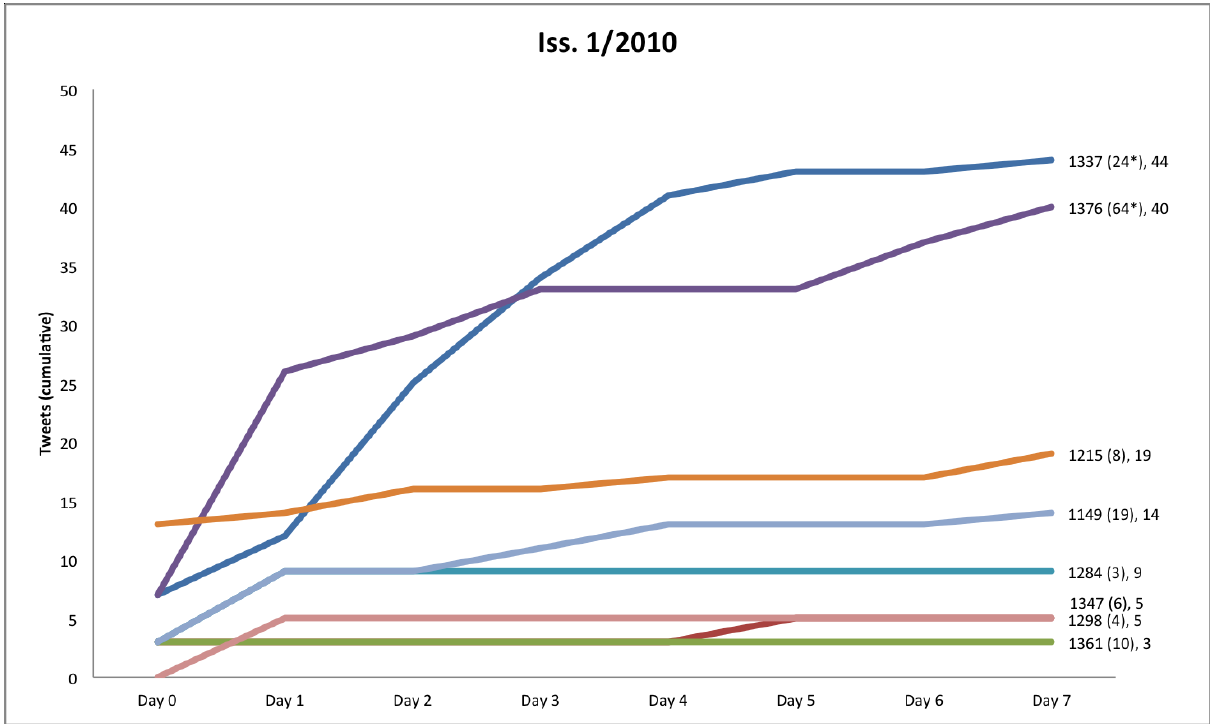
Figure 5. Tweetation dynamics in the first 7 days after article publication for one specific issue. The 4-digit number is the article identifier (last digits of the DOI), number in parentheses is the citation count (as per Google Scholar, November 2011), and the last number is the (cumulative) number of tweets on day 7